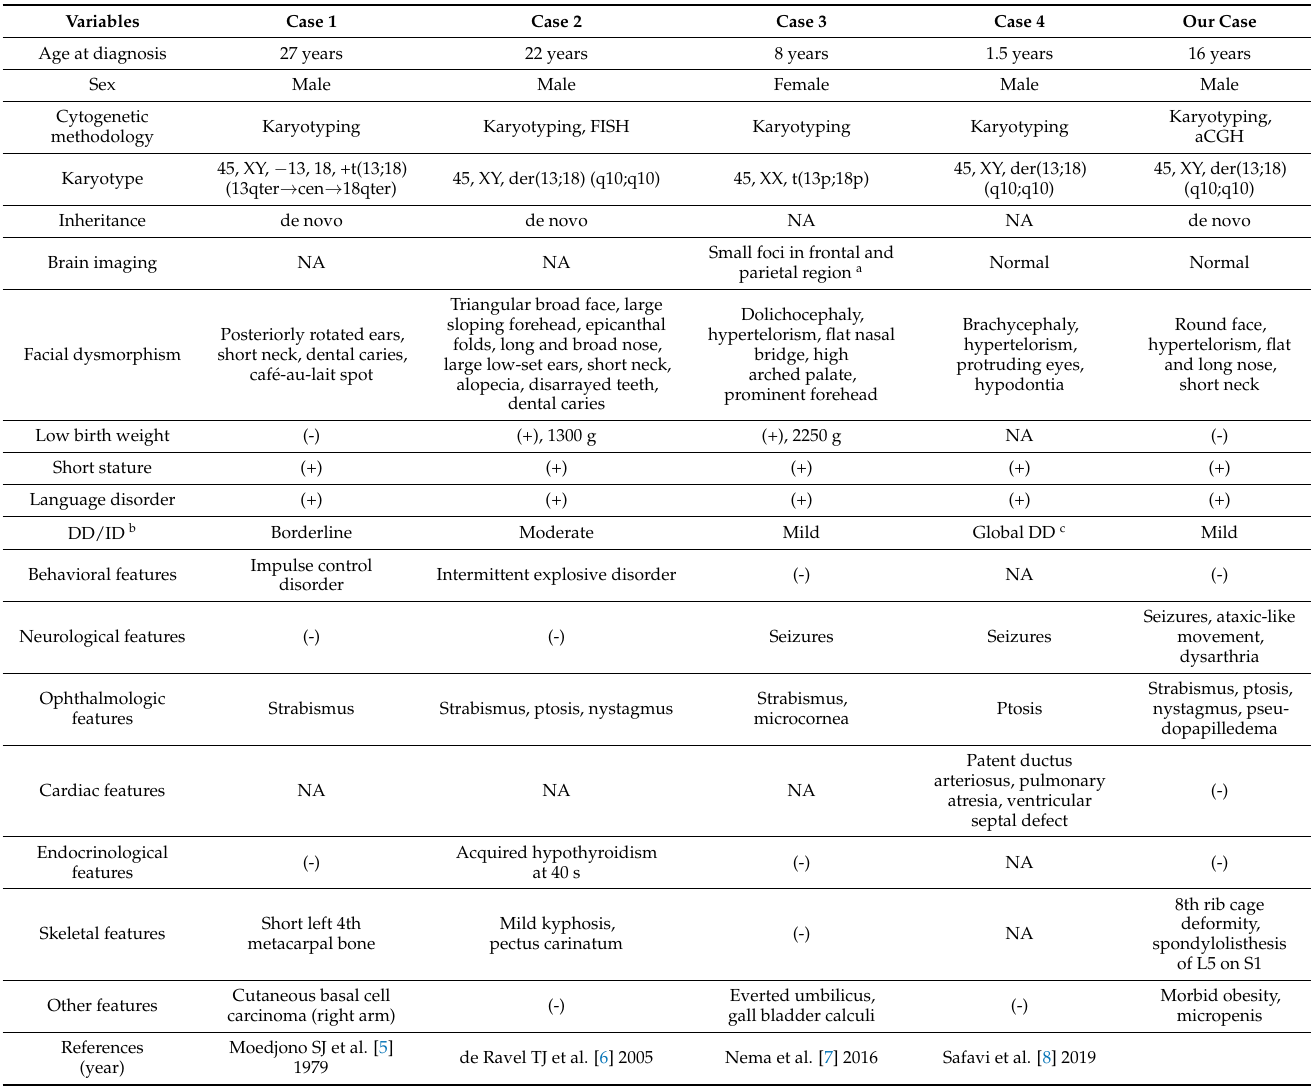
Table 1. Summary of the clinical characteristics and results of 18p deletion syndrome with transloca- tion between chromosomes 13 and